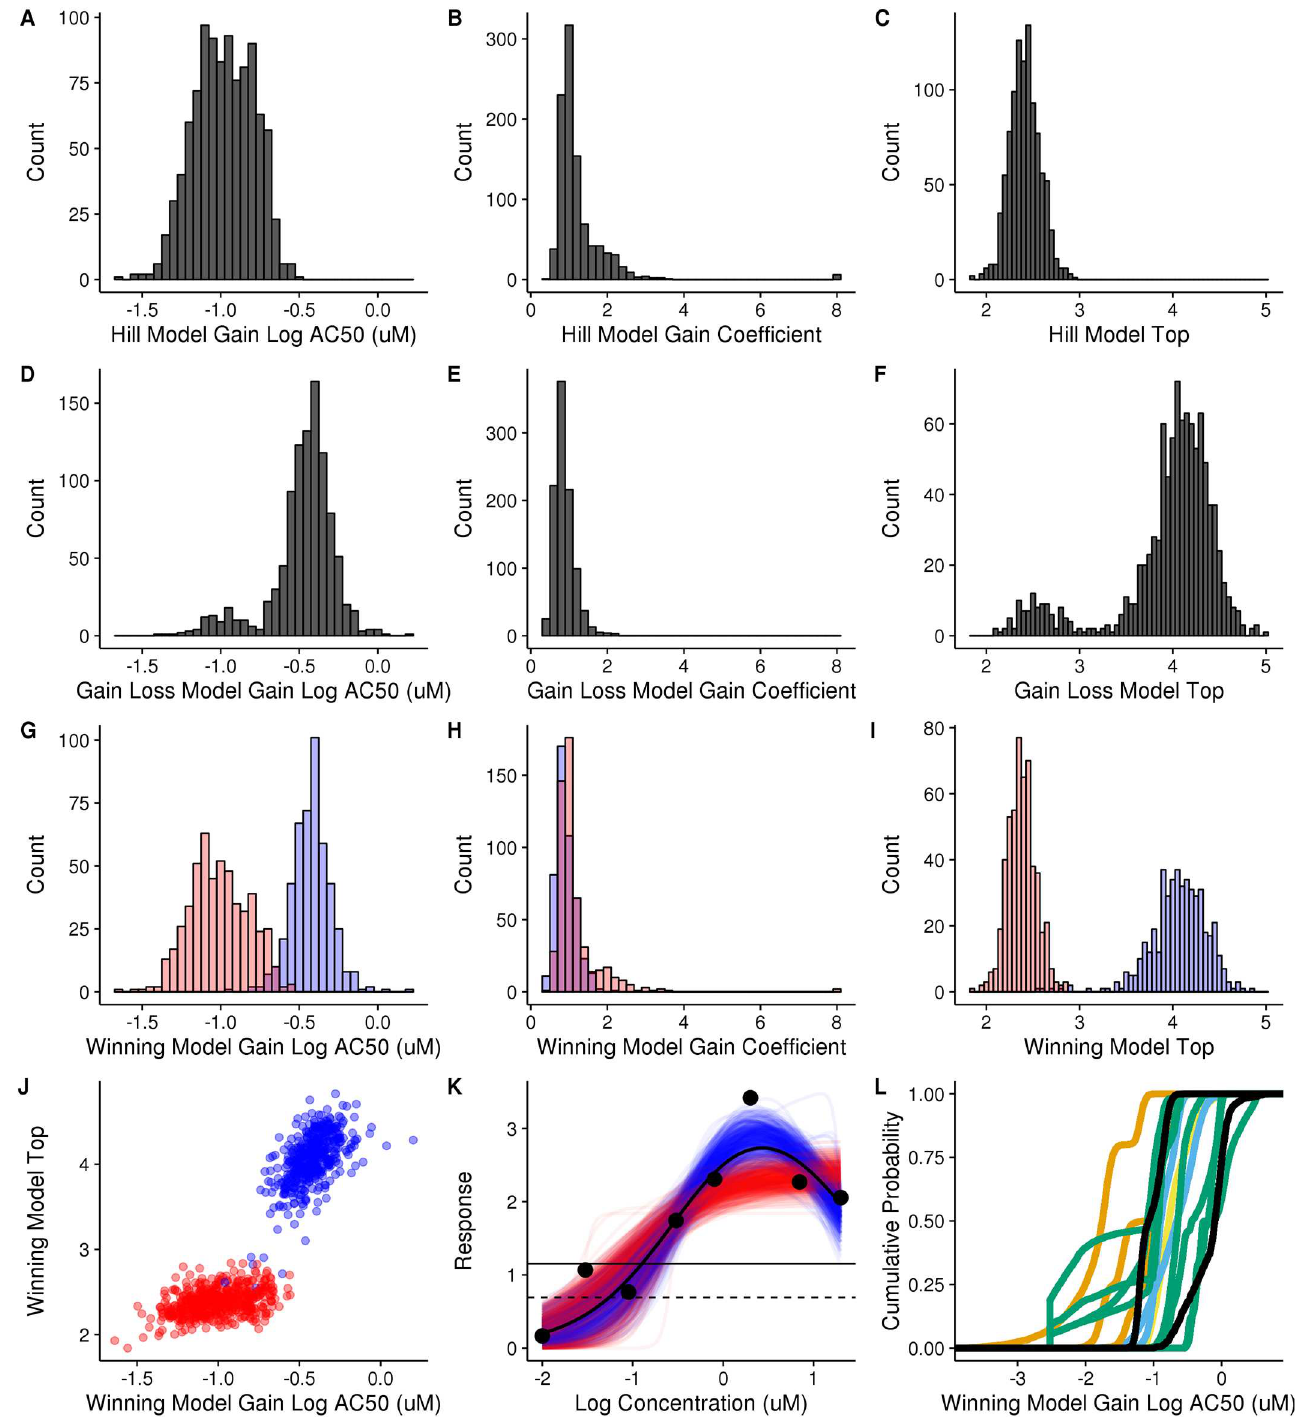
Fig 2. Analysis of bootstrap distribution of model parameters for bisphenol AF in ATG_ERa_TRANS_up assay. A-C : Values for the hill model log(AC50) (A), coefficient (B), and top (C) parameters for all 1000 bootstrap samples. D-F : Values for the gain loss model gain log(AC50) (D), gain coefficient (E), and top (F) for all 1000 bootstrap samples. G-I : Values for the winning model gain log(AC50) (G), gain coefficient (H), and top (I) for all 1000 bootstrap samples, colored by winning model (hill = red, gain loss = blue). J : Correlation plot of winning model top vs. winning model gain log(AC50), colored by winning model (hill = red, gain loss = blue). K : Normalized experimentally measured values (black circles) and winning model (gain loss, black curve). Subset of fitted bootstrap resamples, with winning hill (red lines) and gain loss (blue lines) models plotted. Horizontal black lines represent 3x bmad (dashed) and activity cutoff (solid). L :